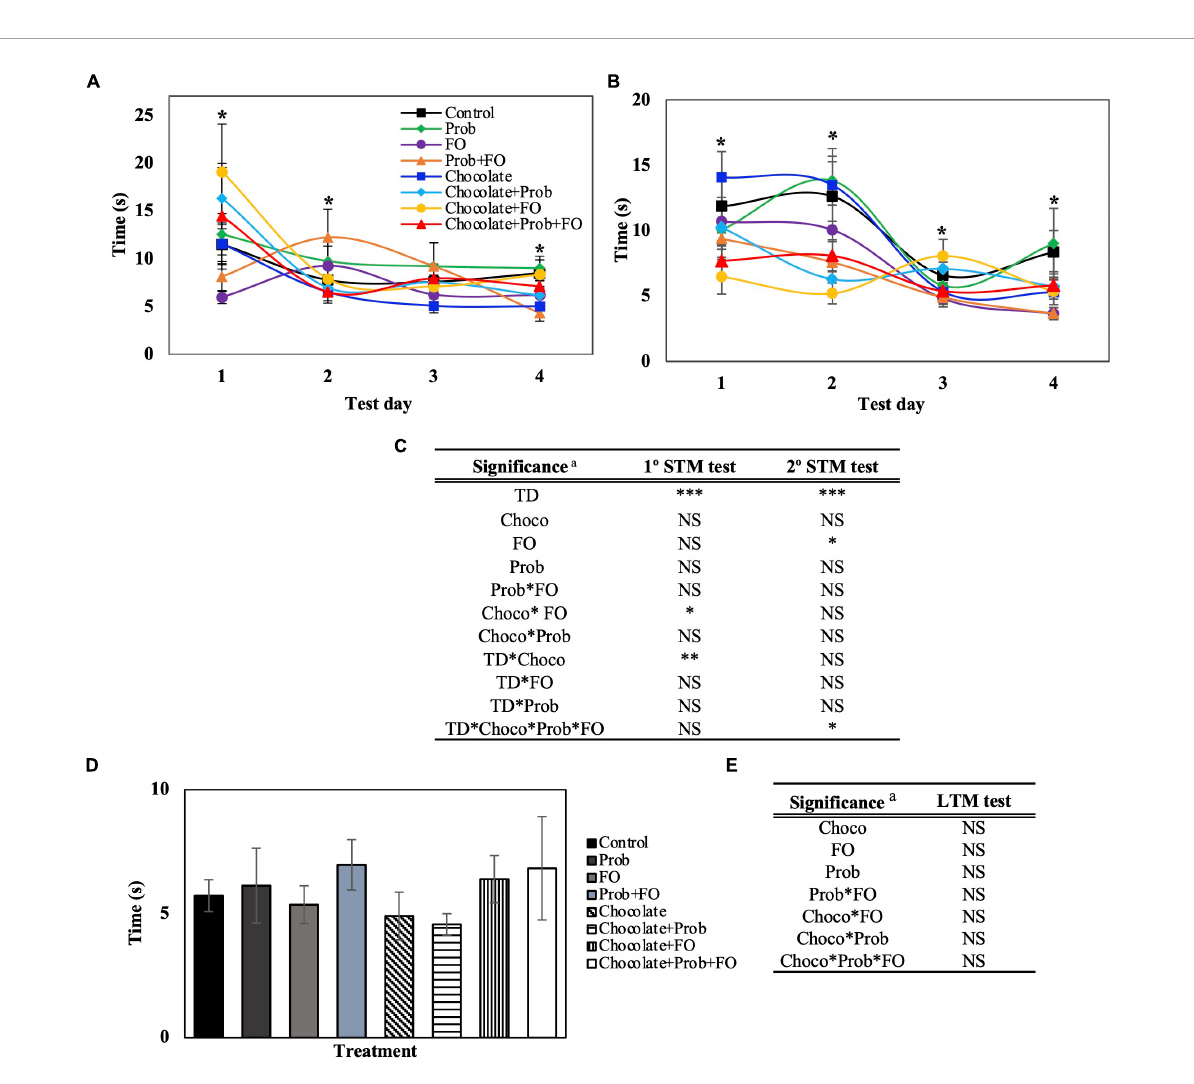
FIGURE3 Latency in the escape zone of rats using the Barnes Maze test. STM, short-term memory; LTM, long-term memory; TD, test days; Choco, chocolate; FO, fish oil; Prob, probiotics; NS, non-significant. a Asterisks (*) indicate significant difference LSD test: * p < 0.05, ** p < 0.01, *** p < 0.001. (A) First session of STM test, (B) Second session of STM test (after 45 min), (C) Significance of treatments interactions and test days on the first and second STM test, (D) LTM test (7th day), (E) Significance of treatment interactions and test days on the LTM test. Values are means ( n = 8), and bars indicate the standard error of the